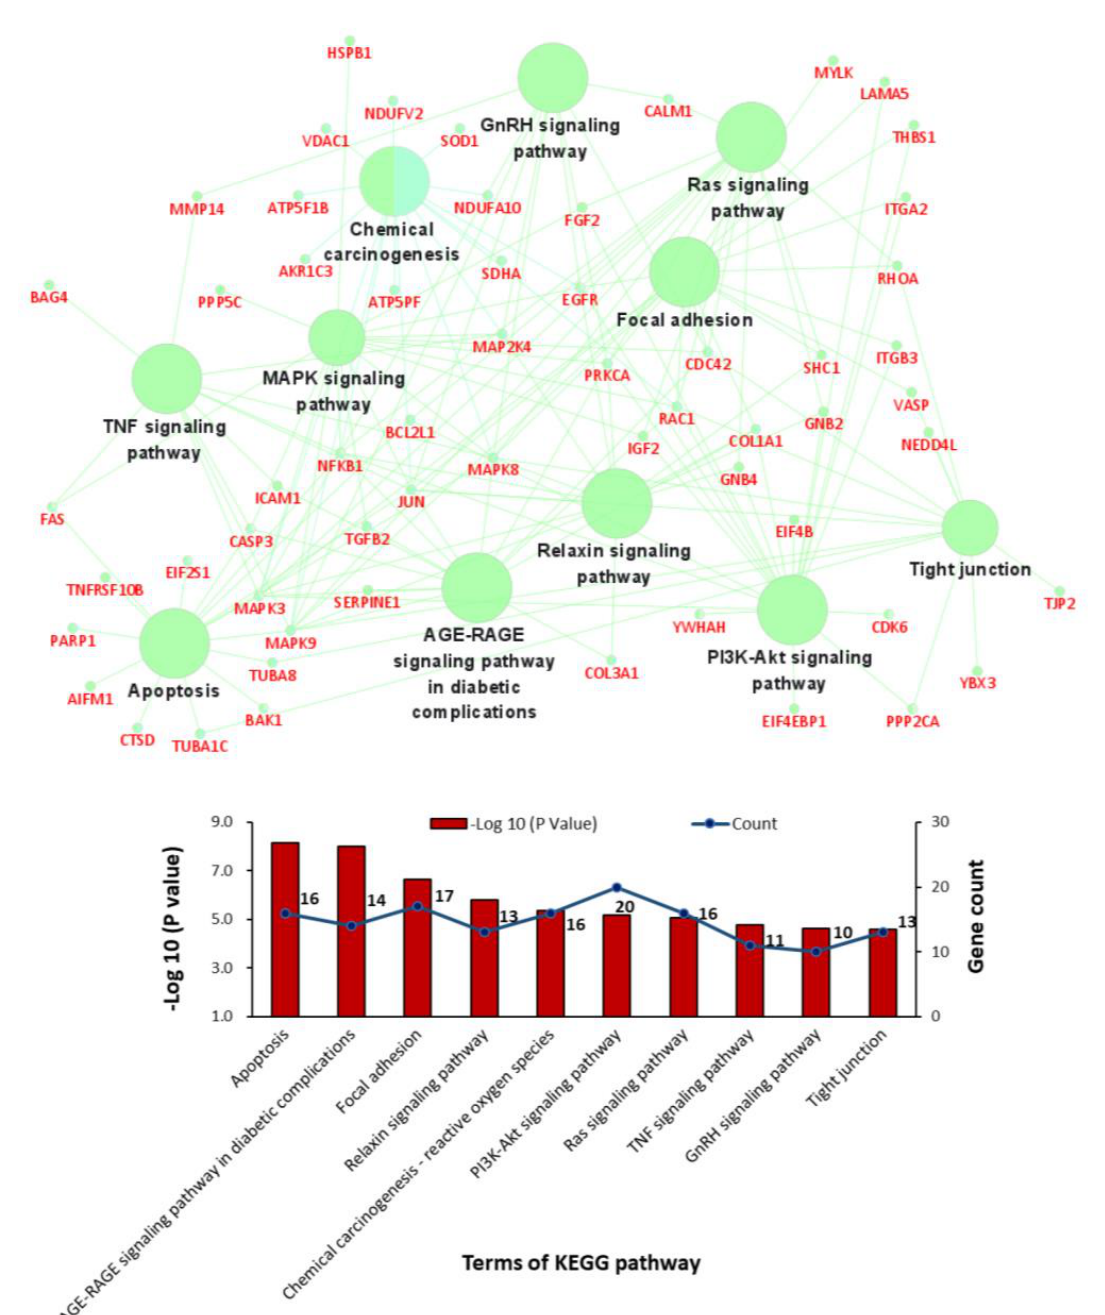
Figure 4. Bar charts and networks of the KEGG pathway enrichment analysis results.